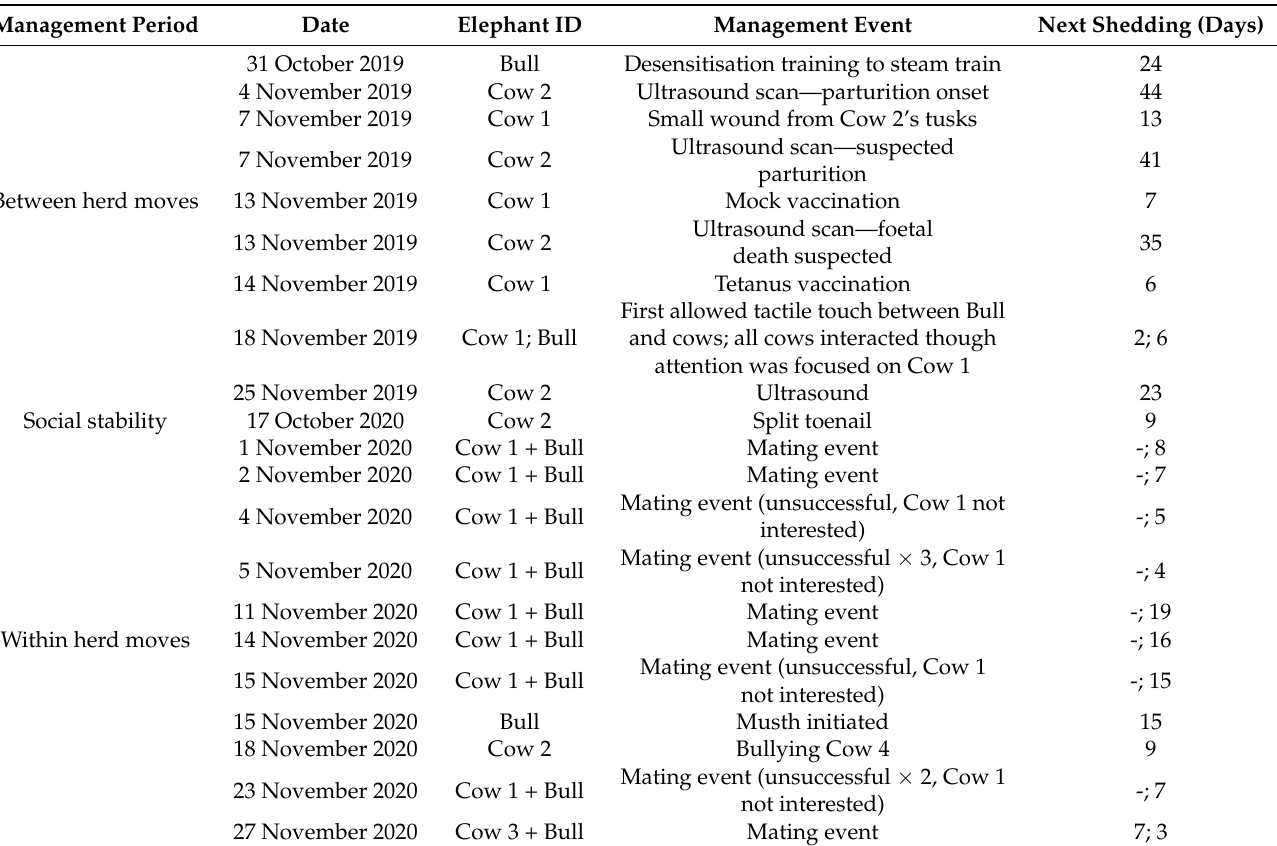
Table 2. A list of notable management events occurring throughout the study period which may have influenced EEHV recrudescence. Data was extracted from keeper management diaries to identify a broad correlation with other management events coinciding with shedding. Weekly foot care and training (operant and desensitisation) occurred for each elephant throughout every management period. Veterinary procedures, such as blood draws and injections, also frequently took place during non-excretory periods. Days until the next shedding are presented in order of elephant ID, where “-” indicates no EEHV was detected after the management event within the appropriate